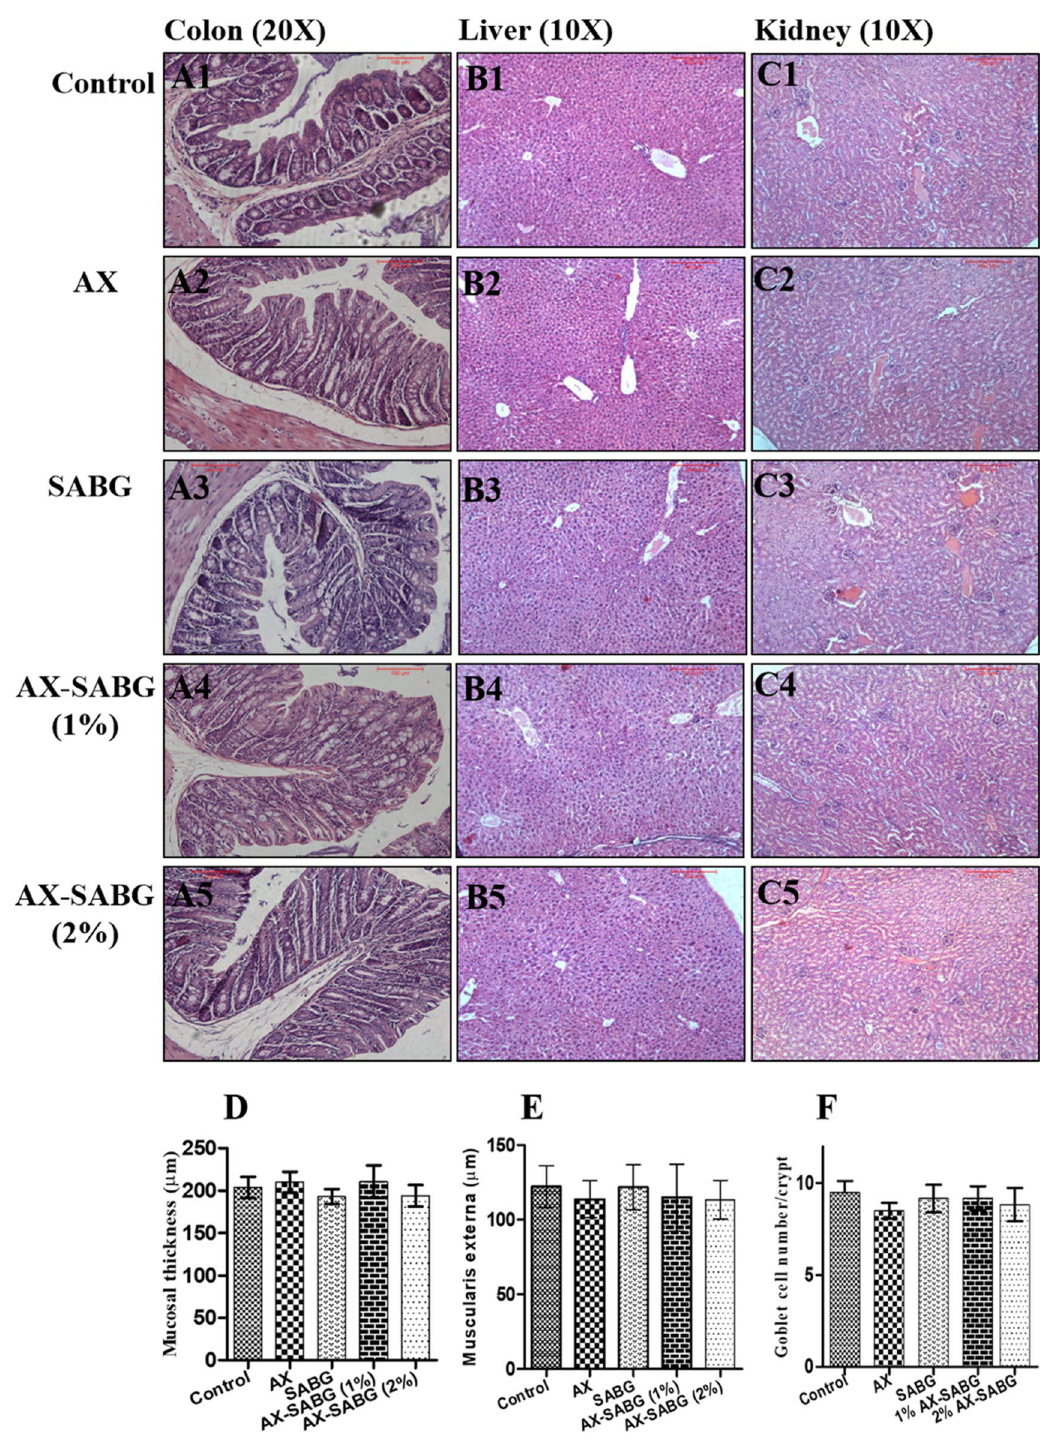
Figure 6. Representative images of histological sections of 28 day sub-acute oral toxicity study on colon (A1– A5) at ×20, liver (B1–B5) at ×10 and kidney (C1–C5) at ×10 of the control and treated groups and the graphs revealing (D) mucosal thickness, (E) muscularis thickness and (F) goblet cell count/crypt in the colon region of the control and treated groups (AX, SABG, 1% AX-SABG and 2% AX-SABG) ( AX arabinoxylan, SABG β-d- glucan stearic acid